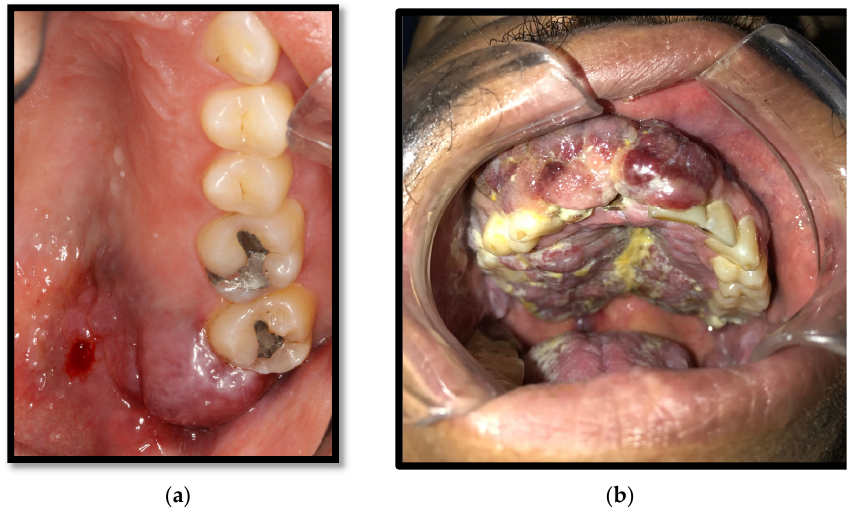
Figure 8. ( a ) Kaposi’s sarcoma in the soft palate and retromolar area; ( b ) Kaposi’s sarcoma of the gingiva, hard, and soft palate. gingiva, hard, and soft